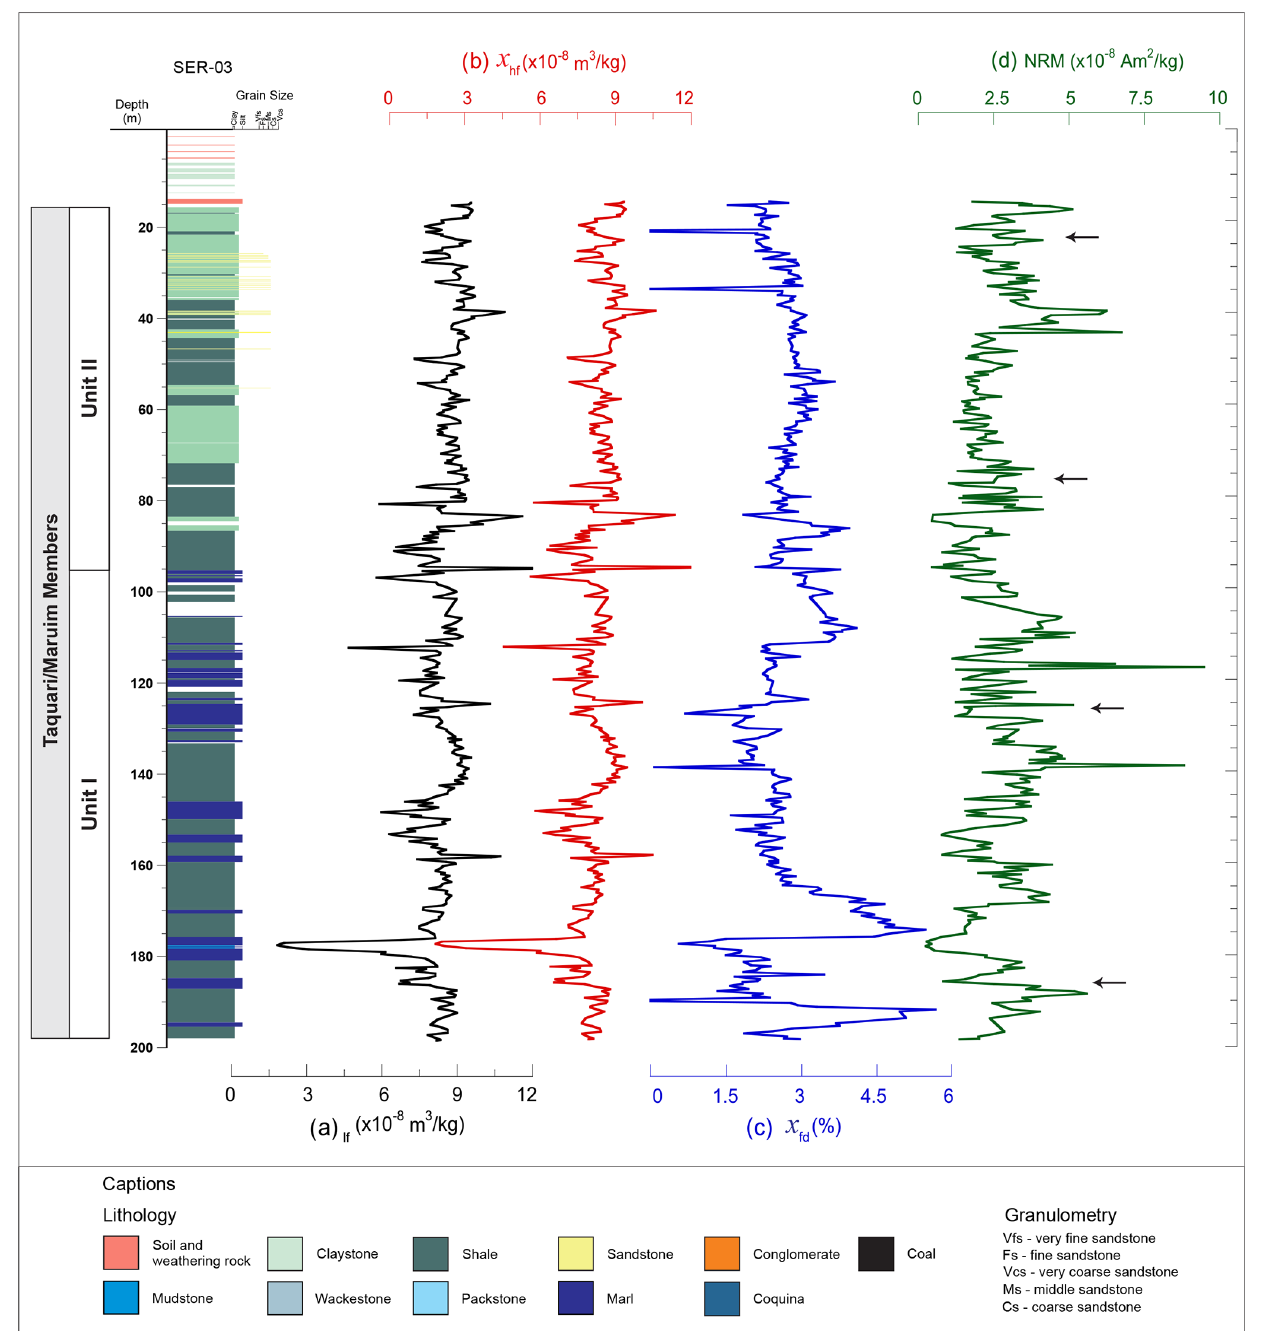
Figure 7. Magnetic susceptibility in low-frequency (a) , high-frequency (b) , and frequency-dependent susceptibility (c) data of 368 samples from core SER-03. Natural remnant magnetization (NRM) of 368 samples from core SER-03 is also show. The positions of the paleomagnetic samples in Fig. 8 are indicated by black